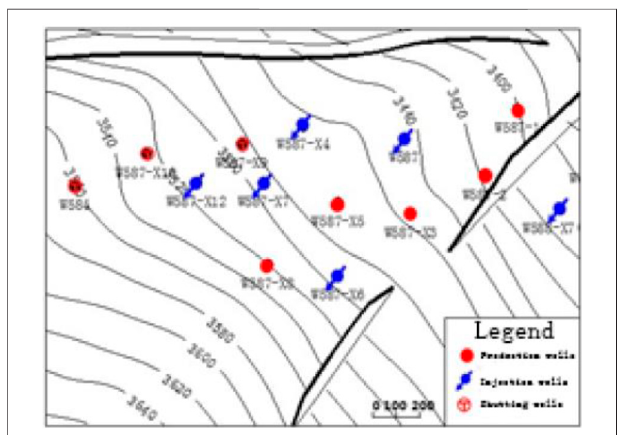
FIGURE 6 | The top structure diagram of the No. 3 sand formation, member 4 of Shahejie Formation in the Wang 587